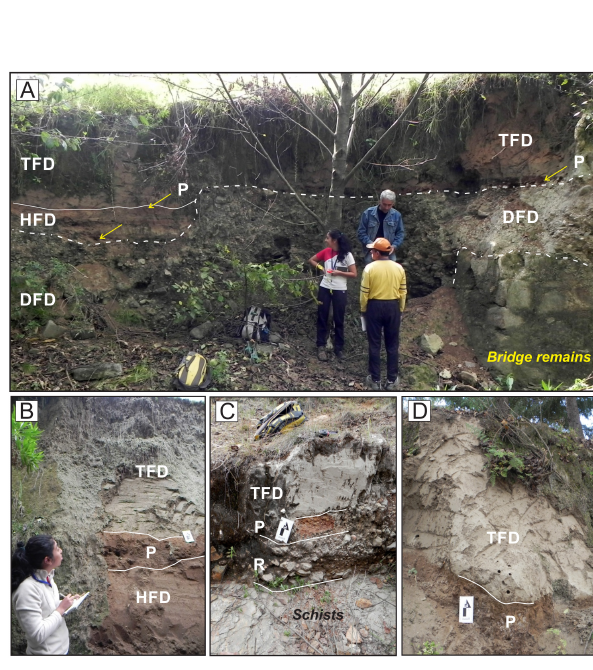
Figure 10. Aspects of the tailings flood deposit (TFD) at three sec- tions along its path. (a) At section TL-14, the TDF rests over a pa- leosol, a thin hyperconcentrated flood deposit (HFD), another pa- leosol, and a basal debris flood deposit (DFD) that contains pieces of bottle glass. The TFD forms a paleo-channel that stands against the remains of an old stone bridge. (b) View of the TFD at sec- tion 17 overlying a paleosol and a lower brown hyperconcentrated flood deposit (HFD) rich in sand-size particles. (c) At section TL-18 the TFD overlies a poorly developed paleosol, a reworked bed with gravel-sized fragments and schists from the local basement. (d) At section TL-19 the deposits rest directly on top of a thicker